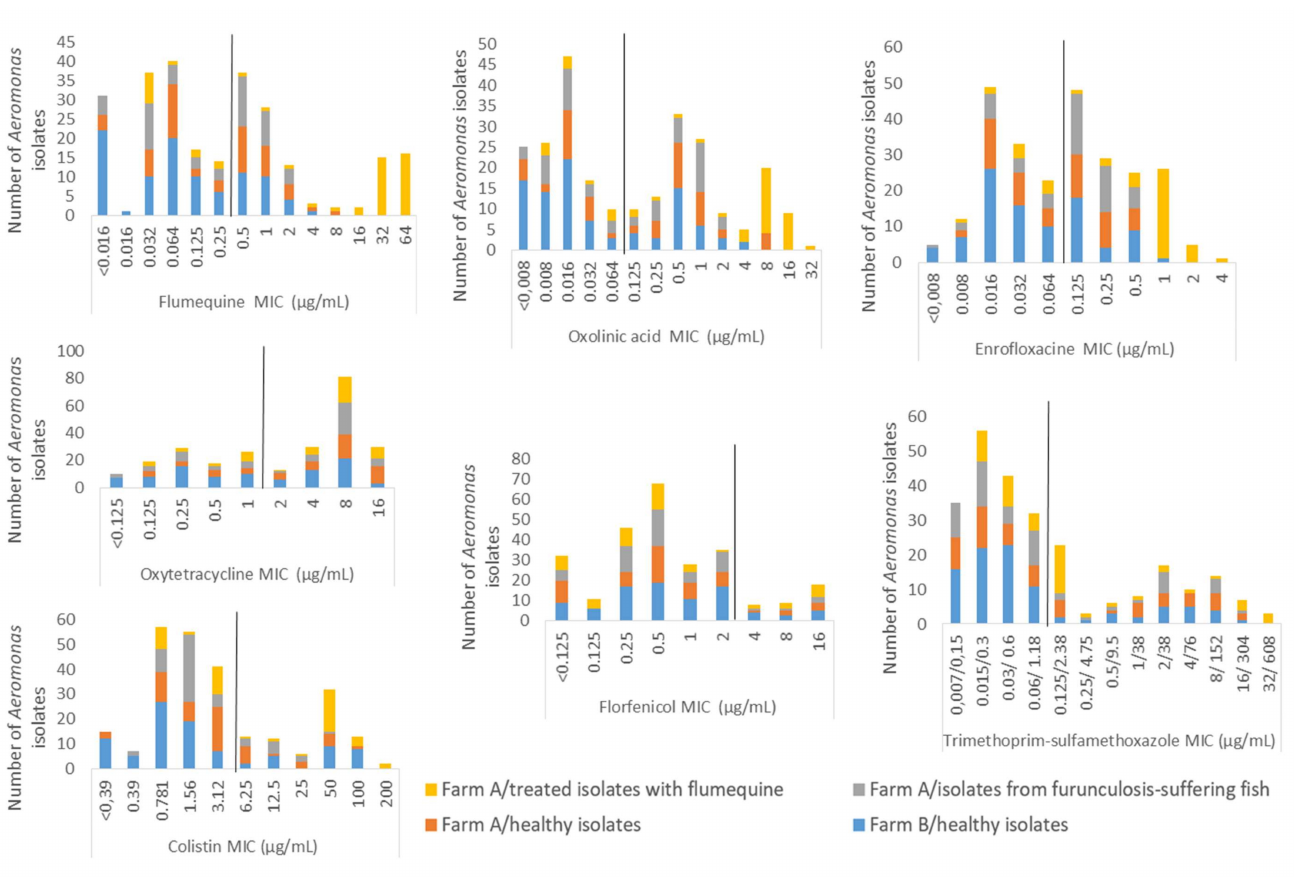
Figure 1. The distributions of antimicrobial susceptibility of 257 Aeromonas strains isolated from healthy, furunculosis- suffering and flumequine-antibiotic-treated fish and their environment for antibiotics tested on two fish farms (A and B). The calculated COWTs are shown with a bar to define the wild-type (before the bar) and non-wild-type (after the bar) populations in this